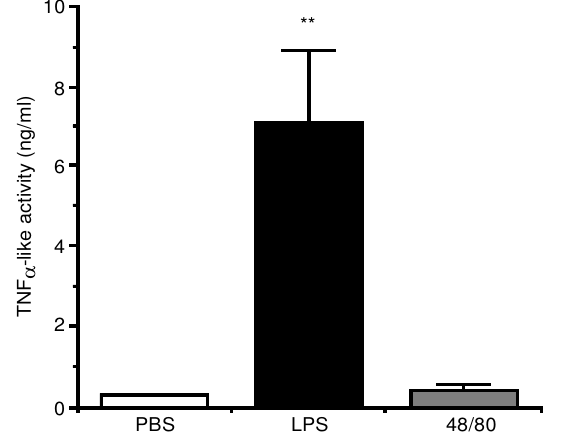
FIG. 2. Ability of LPS (200 ng, 2 h) and of compound 48 / 80 (250 m g, 2 h) to generate the TNF a -like activity in the rat air pouch. The TNF a -like activity was evaluated for LPS and compound 48 / 80 from the supernatants of pouch washing. Results are expressed as mean SEM of TNF a -like activity concentration for n = 4 in the PBS group ( h ), n = 9 in the LPS group ( j ) and n = 5 in the compound 48 / 80 group ( ). ( P , 0.05, P , 0.01).